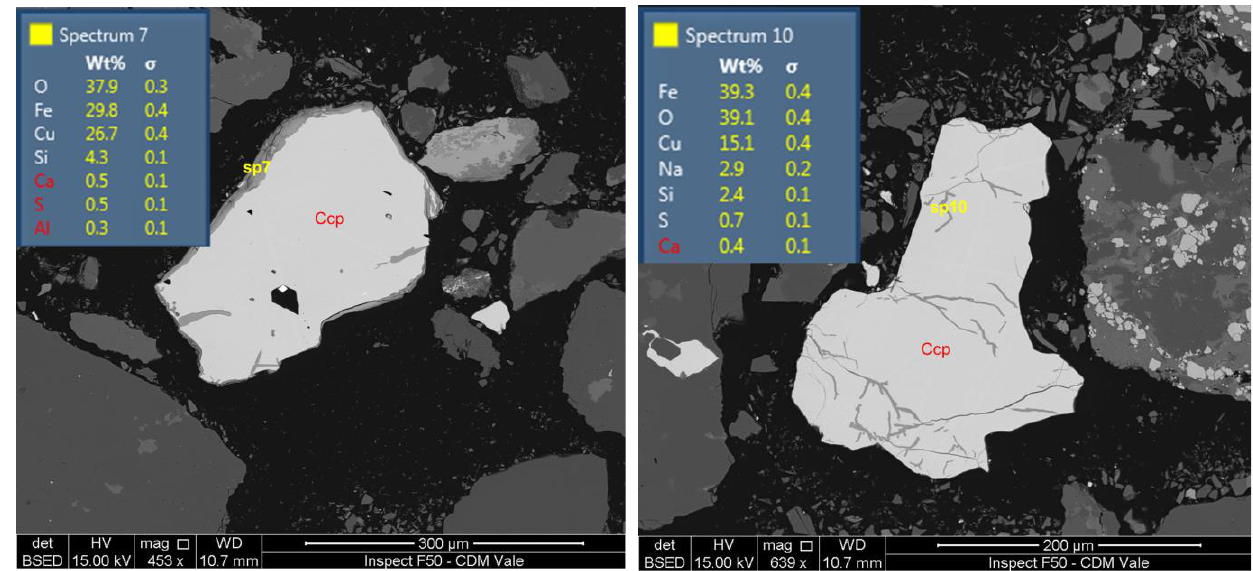
Figure 8. Backscattered electron images of sample 10Y-GRB-Bulk with EDS analysis, showing the alteration of chalcopyrite (Ccp) to Cu-Fe oxides.